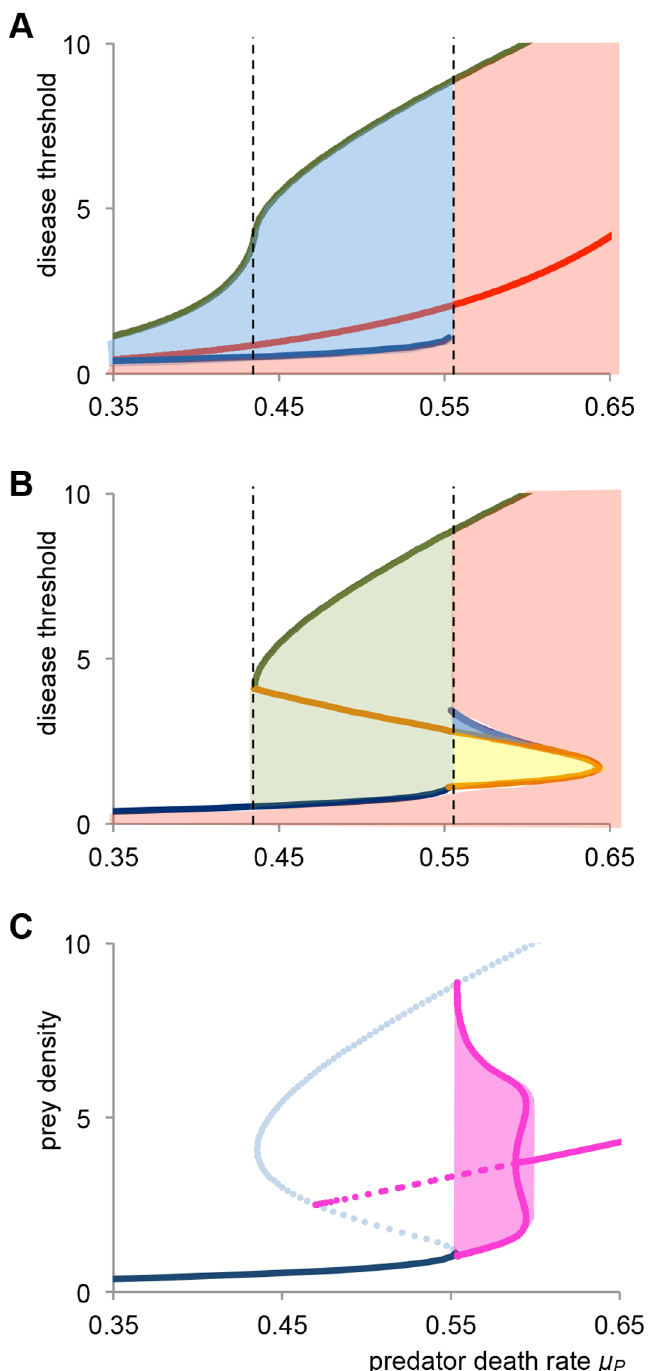
Fig 4. Dynamics for varying disease invasion threshold. Plotting dynamics as a function of predator death rate μ P , and disease invasion threshold ( μ J + α )/ β . (a) Dynamics for the case of δ = 1. In the white area the disease cannot invade, and in the pink area there is a single endemic equilibrium. The blue area indicates bistability between a stunted endemic state and a non-stunted disease free state. The red line denotes predator extinction. The green and blue line are thresholds below which the disease can invade respectively, the stunted and non-stunted host population. The dashed black lines indicate the disease free region of bistability (b) Dynamics for the case of δ = 0. In the green area only the disease free non-stunted state is stable. The yellow area indicates stable recurrent epidemics, and in the purple area there is bistability